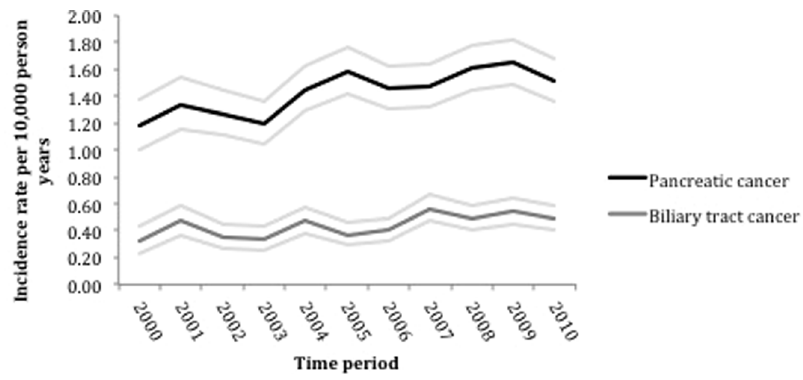
Figure 1. Time trends in PDAC and BTC from 2000–2010 - annual incidence with 95% confidence intervals.